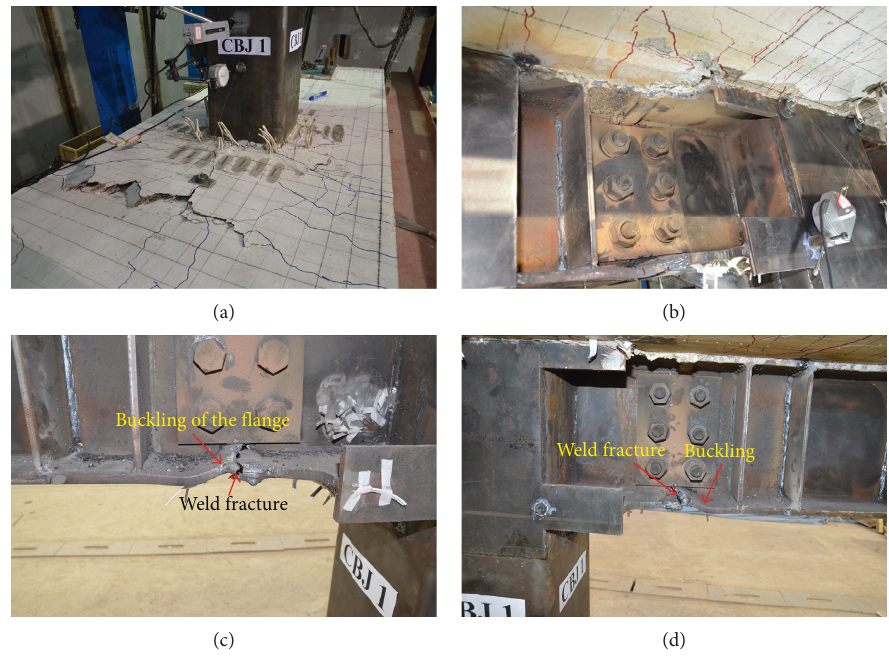
Figure 10: Failure modes of CBJ1: (a) the top of the slab; (b) the bottom of the slab; (c) the left beam; (d) the right